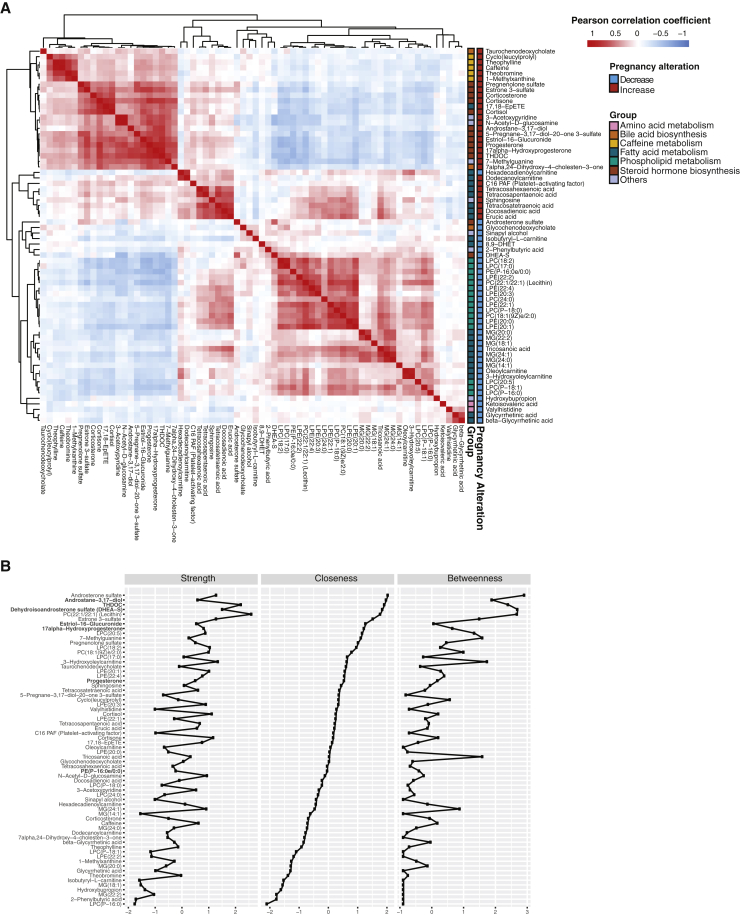
Functional Metabolite Groups Altered during Pregnancy, Related to Figure 2(A) Correlation matrix colored by the Pearson correlation coefficient of each pair of pregnancy-related compounds across samples.(B) The strength, closeness, and betweenness of metabolites in the regularized partial correlation network indicate how important the metabolites are in the network. Metabolite names are listed on the left side ranked by the closeness, with the names of the seven compounds in the prediction models of Figure 4 and Figure 5 (bold).